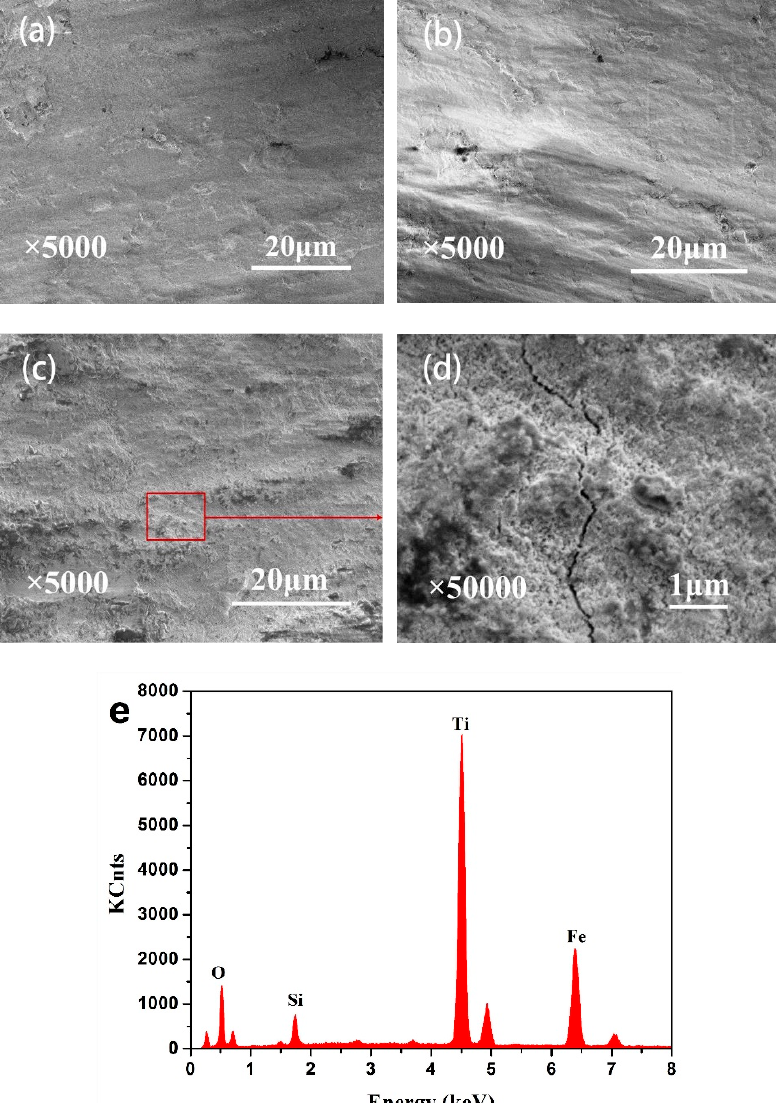
Figure 10. Scanning electron microscope (SEM) morphologies of the wear scars of coatings after the oxidation temperature of 200 ◦ C: ( a ) 1 h and 5000 × magnification; ( b ) 3 h and 5000 × magnification; ( c ) 5 h and 5000 × magnification; and ( d ) 5 h and 50,000 × magnification; ( e ) EDS analysis of the wear scars under the oxidation time of 1 h.